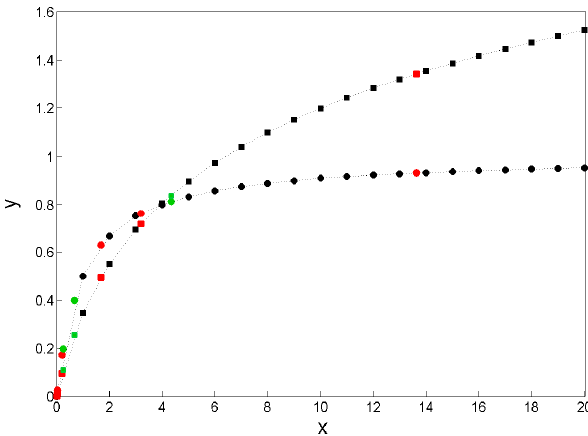
Fig. 2. Curves of y = x / (1+ x ) (black circles) and y =1/2 ln (1+ x ) Figure 2. Curves of y = x / (1 + x) (black circles) and y = 1/2 ln (1 + x) (black squares) (black squares) for x between 0 and 20 and for the eigenvalues of P r that lay within this domain, for O 3 (red) and CO for x between 0 and 20 and for the eigenvalues of P (red) and CO (green).